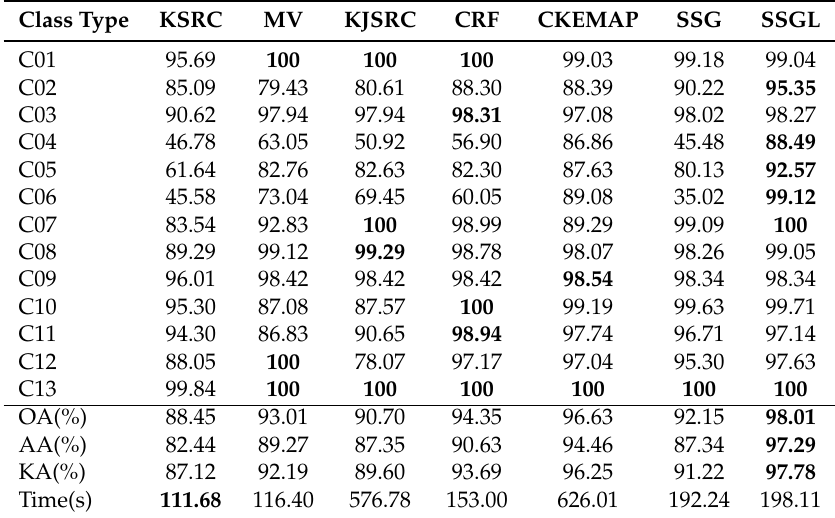
Table 7. Classification accuracies for the AVIRIS Kennedy Space Center dataset using different classification methods. The best results are highlighted in